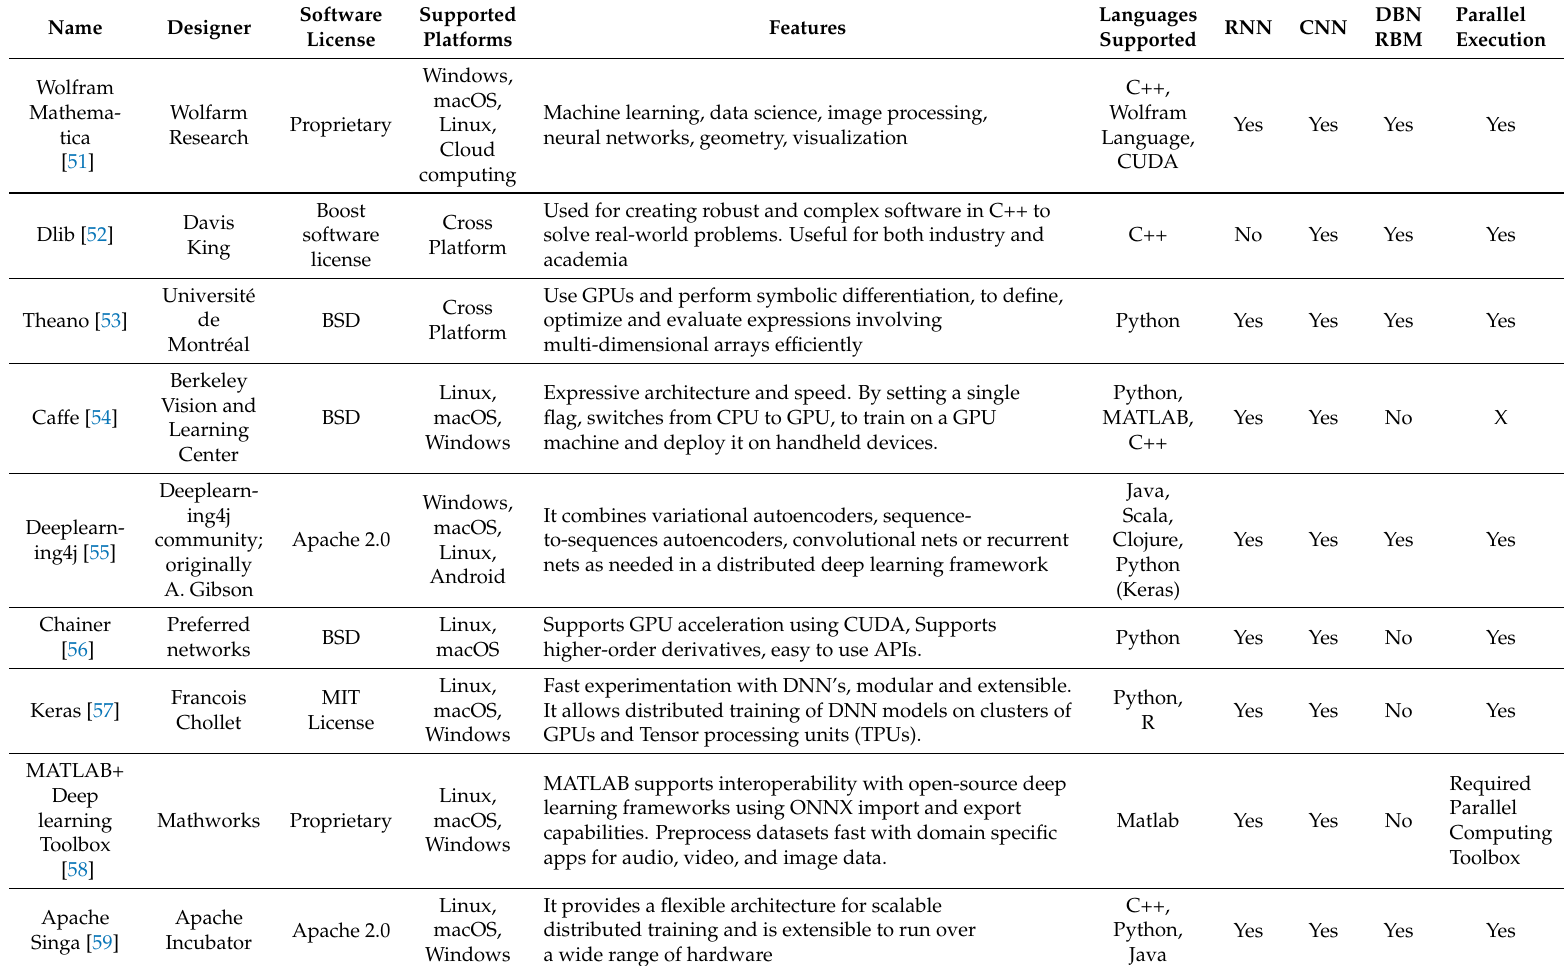
Table 3. Comparison of various deep learning